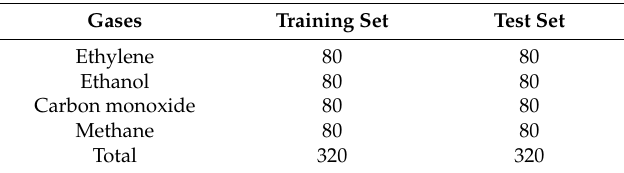
Figure 1 manifests the representative response curves of the sensors for the two